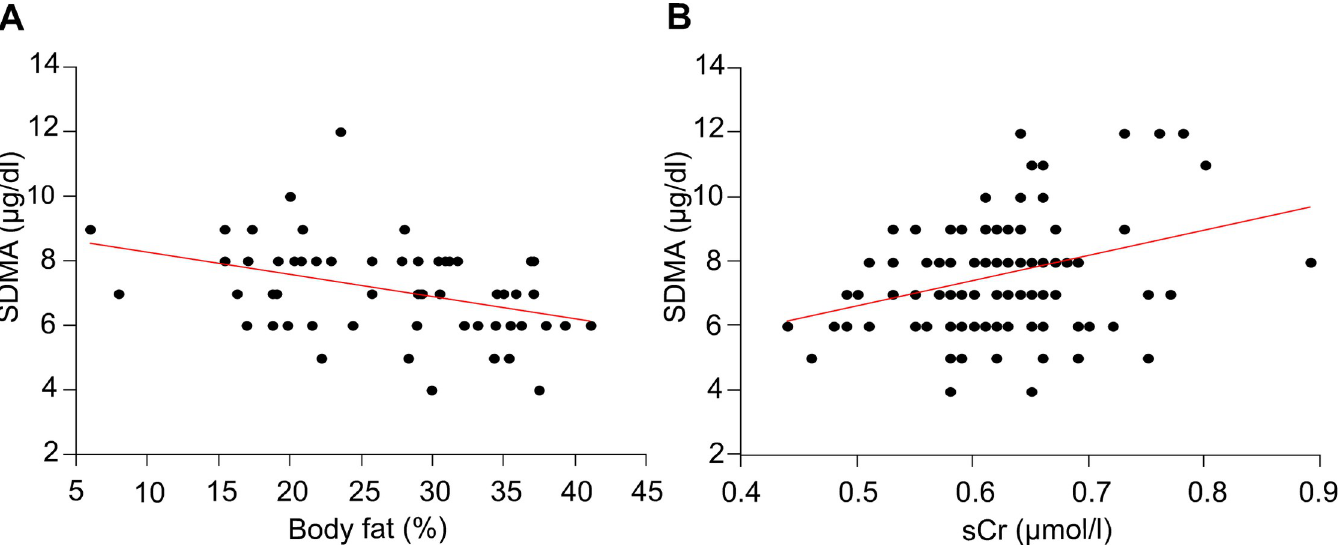
Fig 2. The association of SDMA with body fat percentage (A) and serum creatinine (sCr) (B) in dogs. SDMA showed a significant negative association (coefficient = -0.07) with body fat percentage (p < 0.01) in the weight change group and a significant positive association (coefficient = 7.79) with serum creatinine (sCr) (p < 0.01) in the entire study population a . a Data from 1 dog missing in the control group. SDMA, symmetric dimethylarginine.